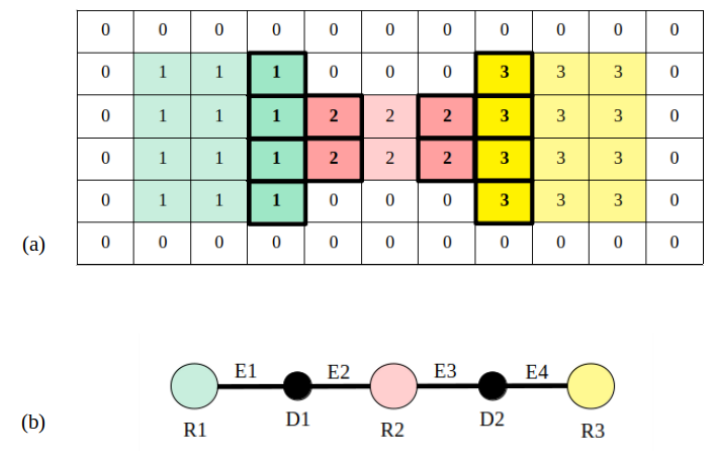
Figure 12. Topological map extraction from room labels: ( a ) Selection of pixels corresponding to doors (highlighted with a black rectangle), ( b ) final topological map, where a node is assigned to each room (R) and door (D), and edges (E) indicate connectivity among